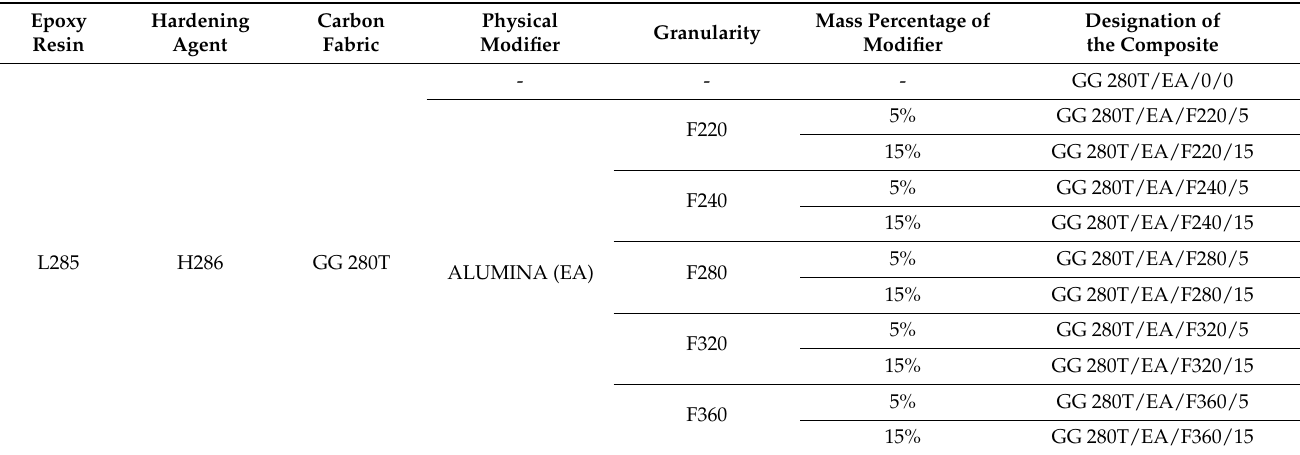
Table 3. Composition and designation of manufactured